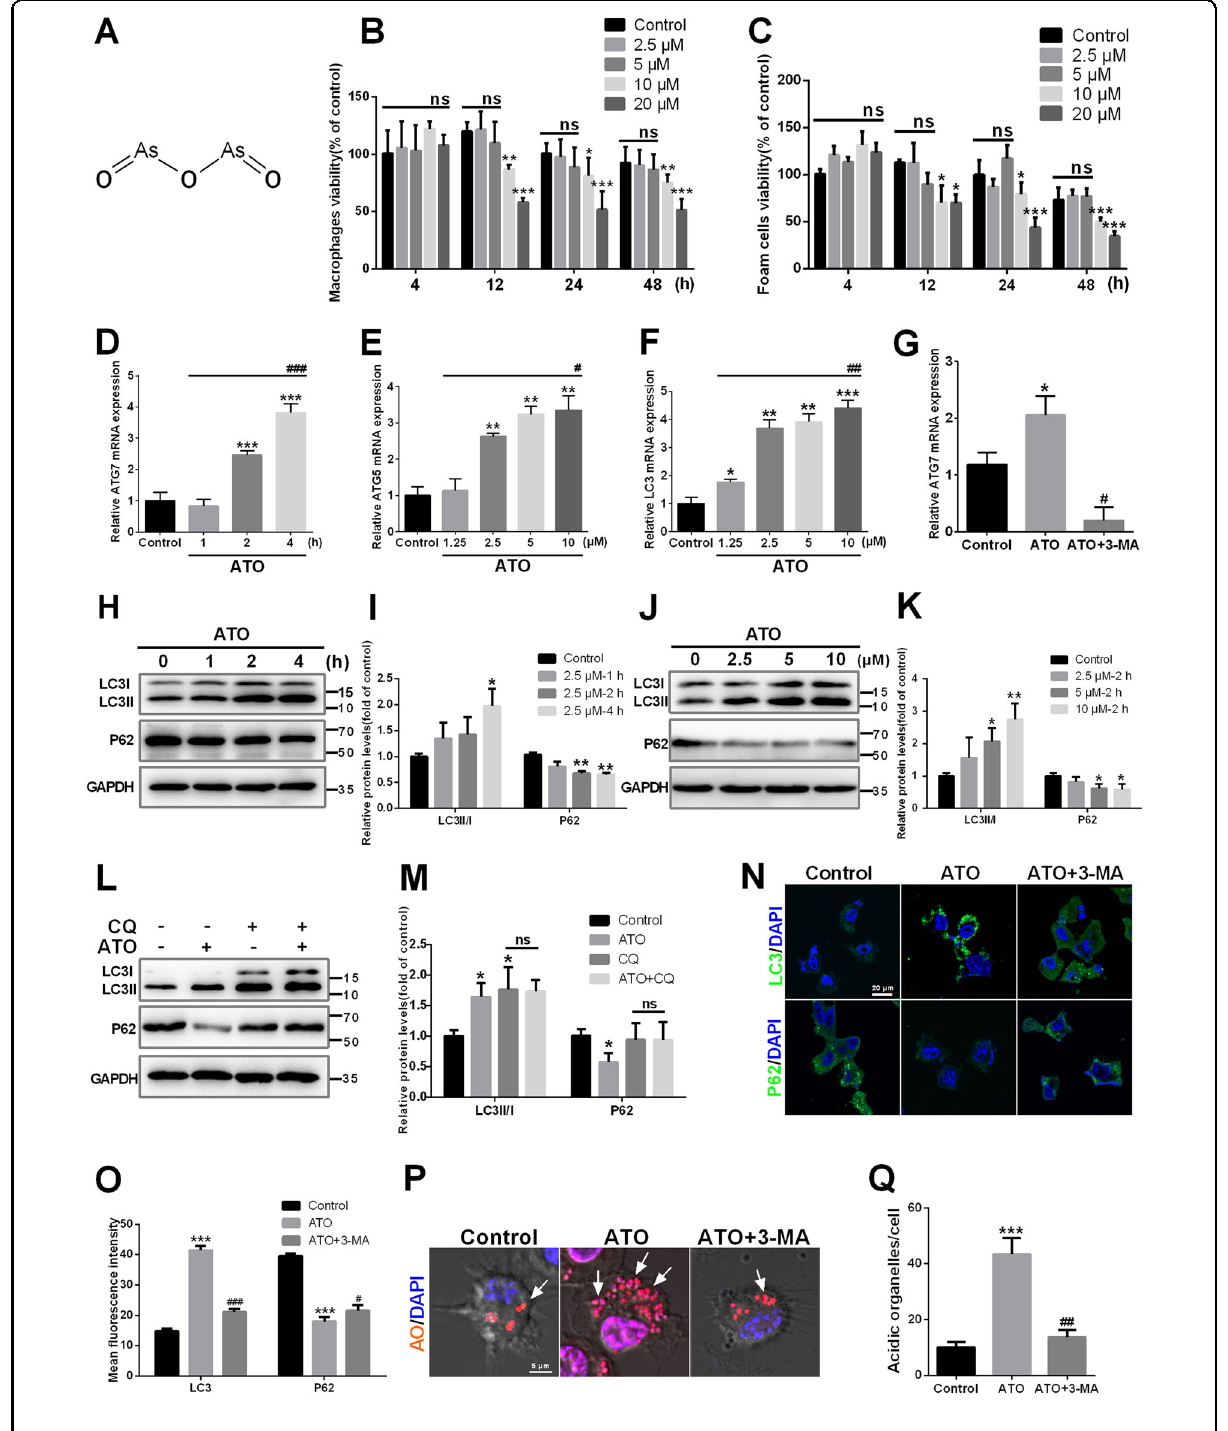
Fig. 1 (See legend on next